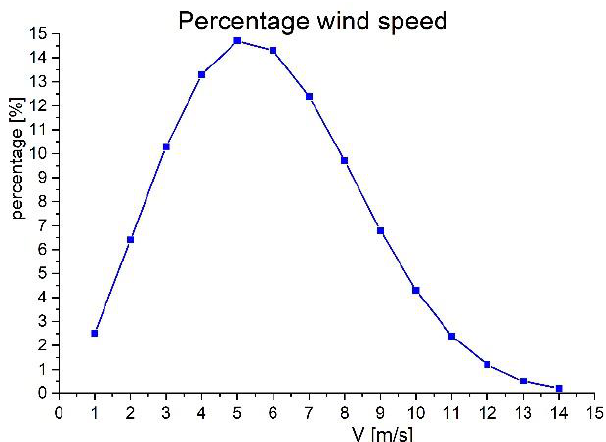
Figure 10. Weibull probability distribution of wind speed for the month of January.